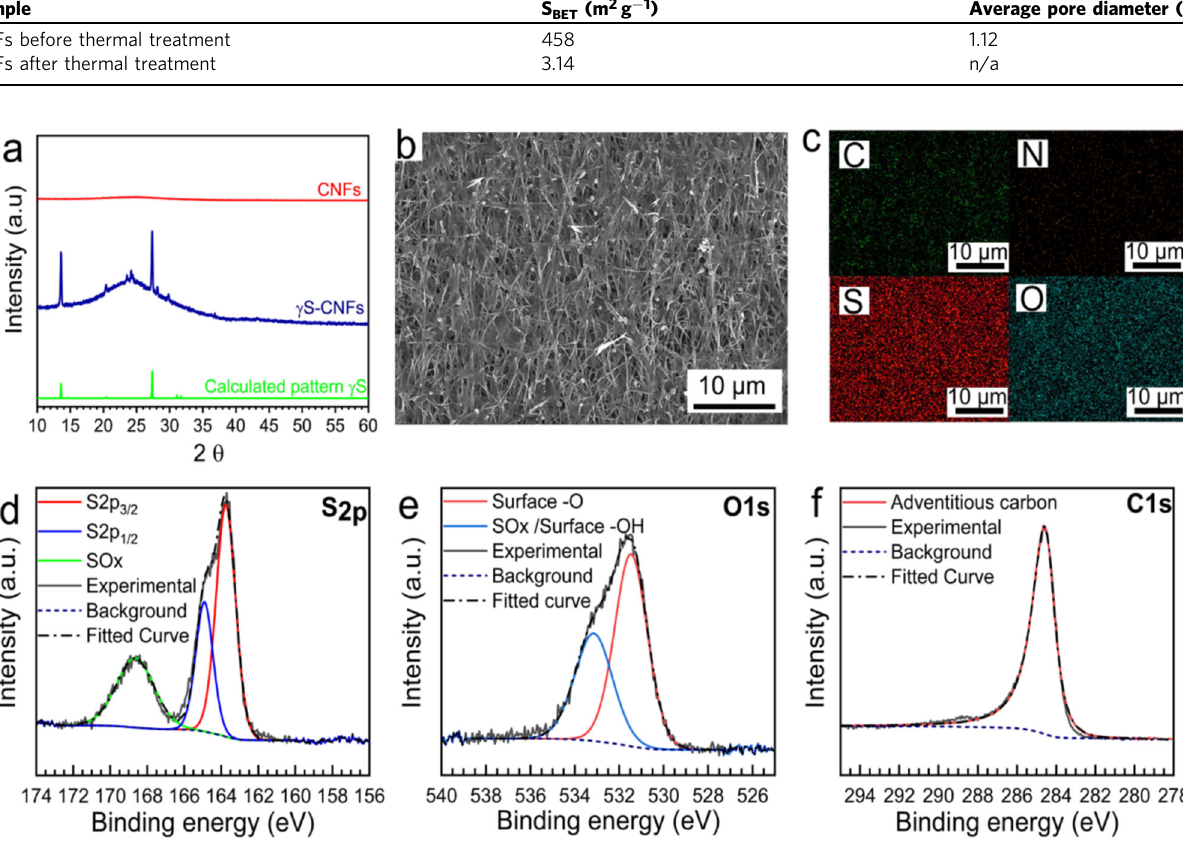
Fig. 3 Phase and surface characterization of CNFs and γ -CNFs. a XRD pattern of CNFs, γ S-CNFs, and calculated pattern of γ S. b , c SEM image of γ S-CNFs showing well-distributed sulfur deposition and EDS elemental mapping. d – f XPS spectra of S, O, and C on the γ